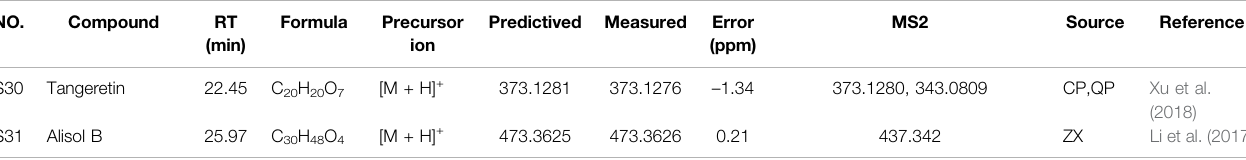
Supplementary Figure S3B , the key targets involving in